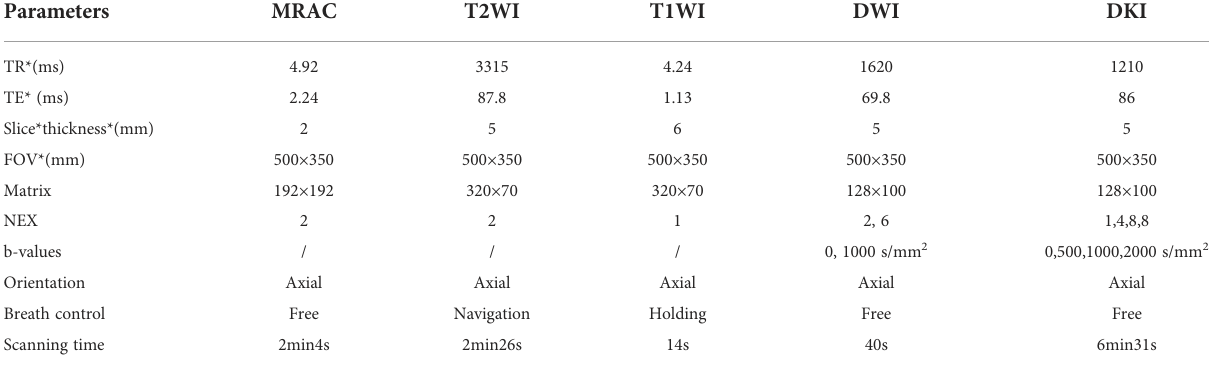
TABLE 1 Imaging protocol